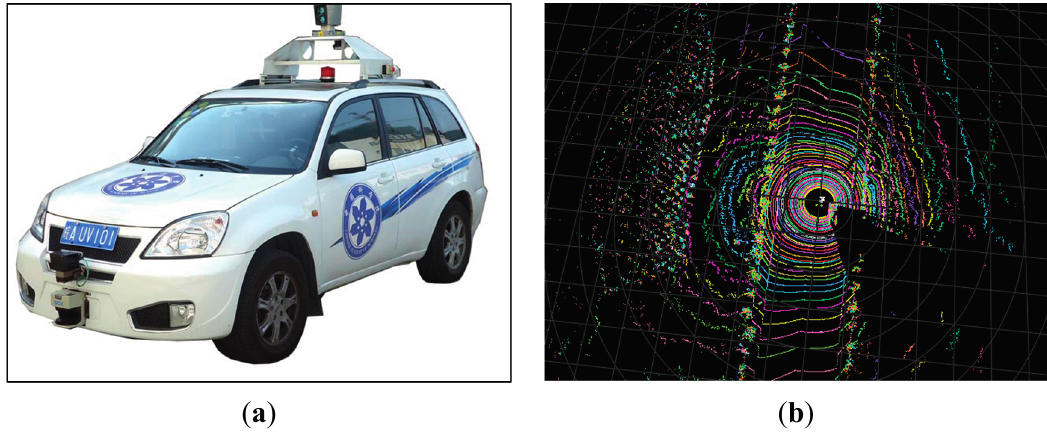
Figure 1. ( a ) The test car; ( b ) A point cloud